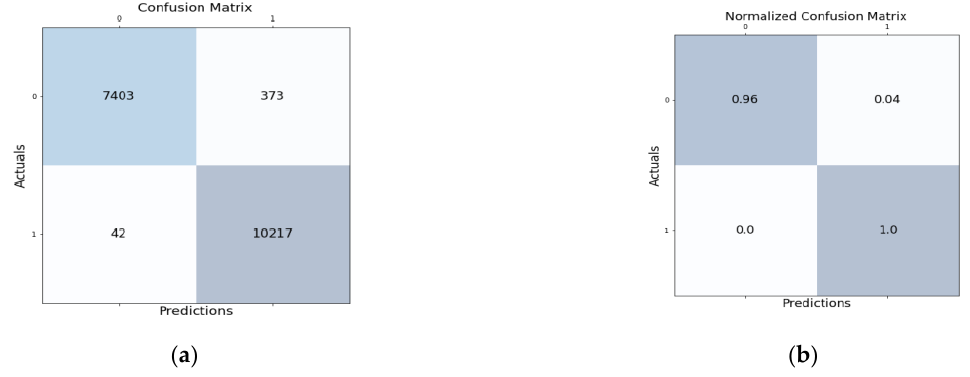
Figure 5. ( a ) Confusion matrix and ( b ) normalized confusion matrix for the proposed HNIDS model for MCC.